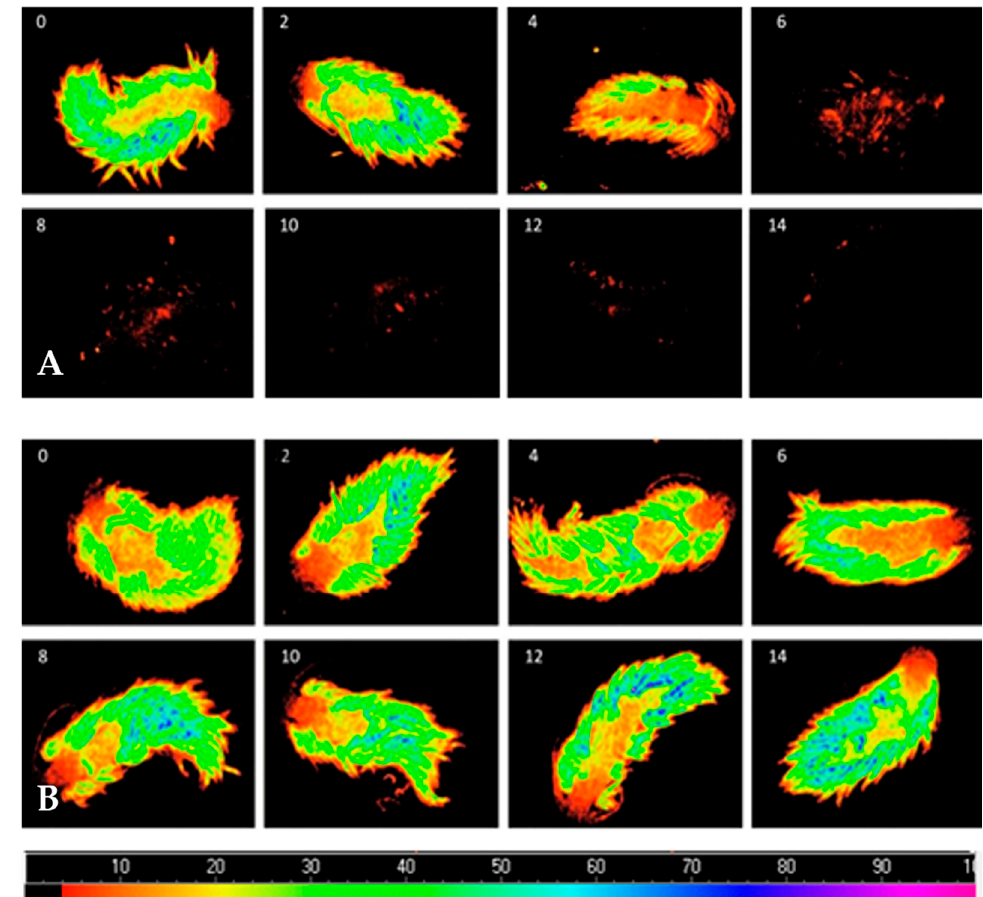
Figure 2. Evolution of the fluorescence parameter F o monitored using an Imaging-PAM fluorometer in Berghia stephanieae enduring starvation ( A ) or being fed with symbiotic anemones ( Exaiptasia diaphana ) for 14 days ( B ). Numbers in the top left corner of each image refer to the number of days under each feeding treatment.